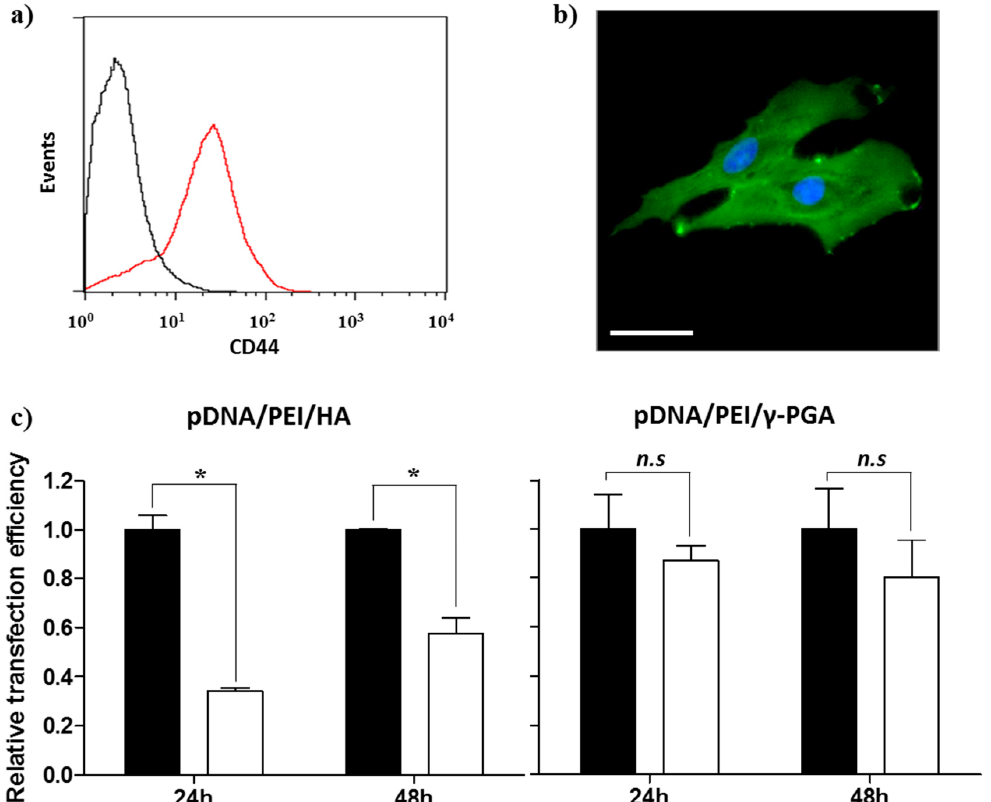
Figure 7. Expression of CD44 in hASCs evaluated by ( a ) flow cytometry and ( b ) fluorescence image. Scale bar = 40 µm. ( c ) Competition assay to investigate the effect of HA pretreatment on the transfection efficiency of pDNA/PEI/HA (left) and pDNA/PEI/ γ -PGA (right) ternary nanocomplexes at 24 or 48 h. ■ = without HA pretreatment, □ = with HA pretreatment. Data are presented as means ± S.E. ( n = 4), * p < 0.05, n.s = not significant vs. untreated control.